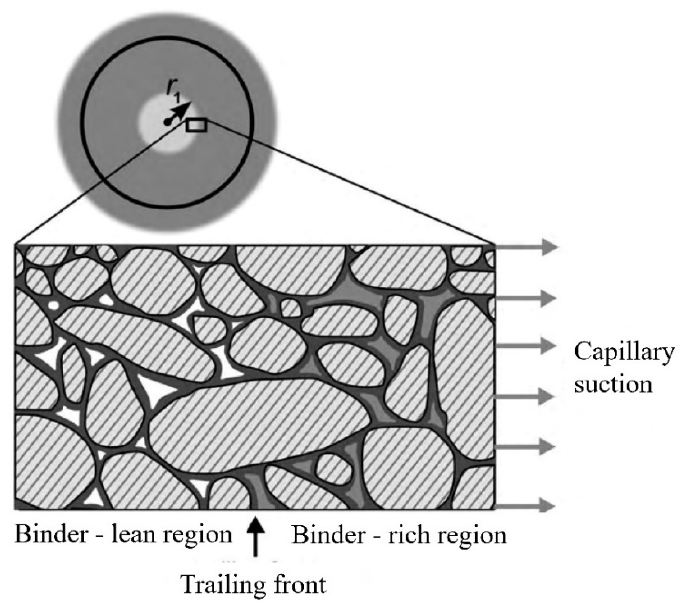
Figure 14. Schematic of the binder system distribution during thermal wick debinding. Reproduced with permission from reference [100], copyright © 2010 Elsevier Ltd.